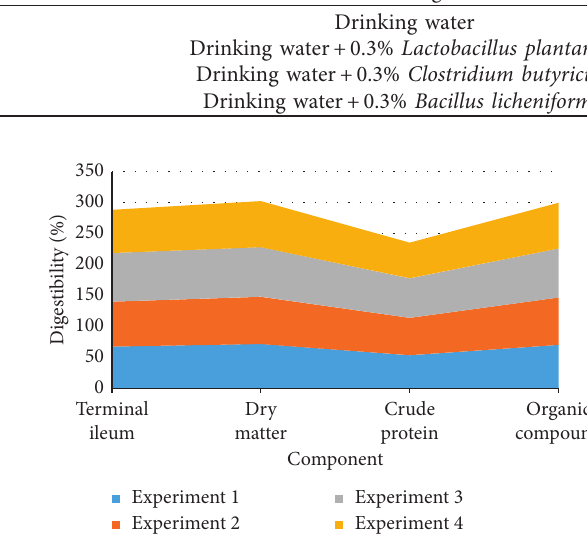
Figure 2: Apparent